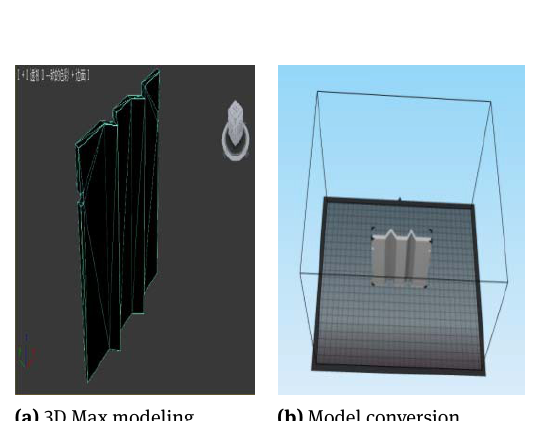
Flatness, porosity of specimens, and fit degree of